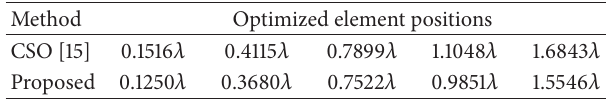
Table 1: Optimized positions of the positive half of the 10-element array of Example 1